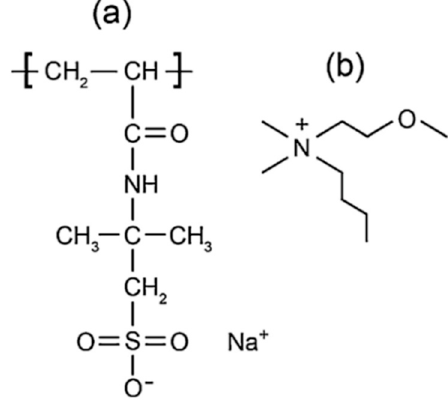
Figure 12. Structure of the ionomer. ( a ) The poly(2-acrylamido-2-methyl-1-propane-sulfonic acid) (PAMPS) monomer and ( b ) the dimethylbutylmethoxyethyl ammonium cation (N114(201)).